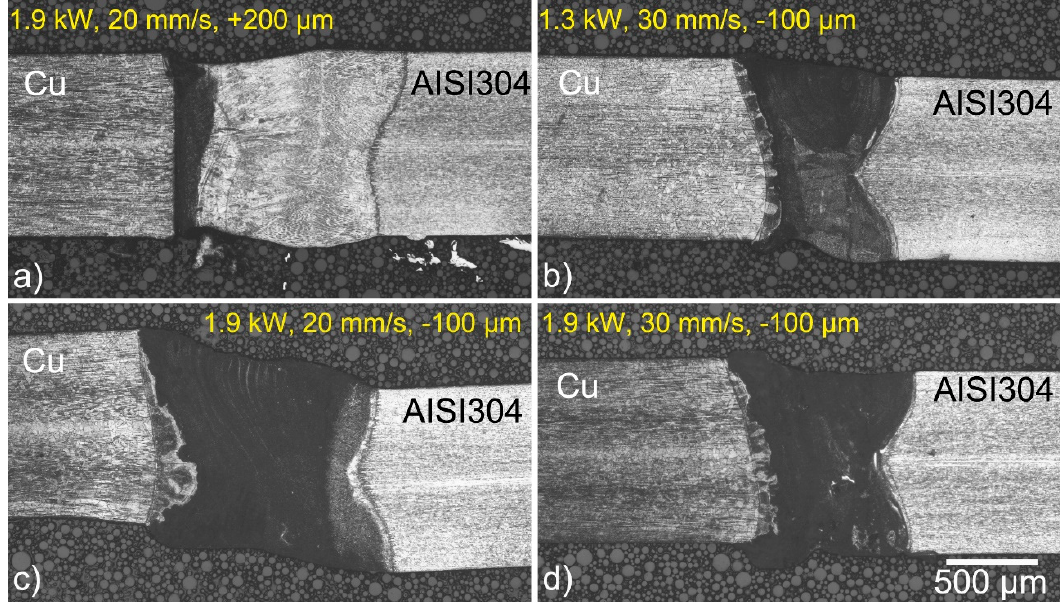
Figure 4. Cross-sections of dissimilar metals-welded joints produced with different welding parameters. ( a ) weld No. 1, ( b ) weld No. 4, ( c ) weld No. 5 and ( d ) weld No. 7.